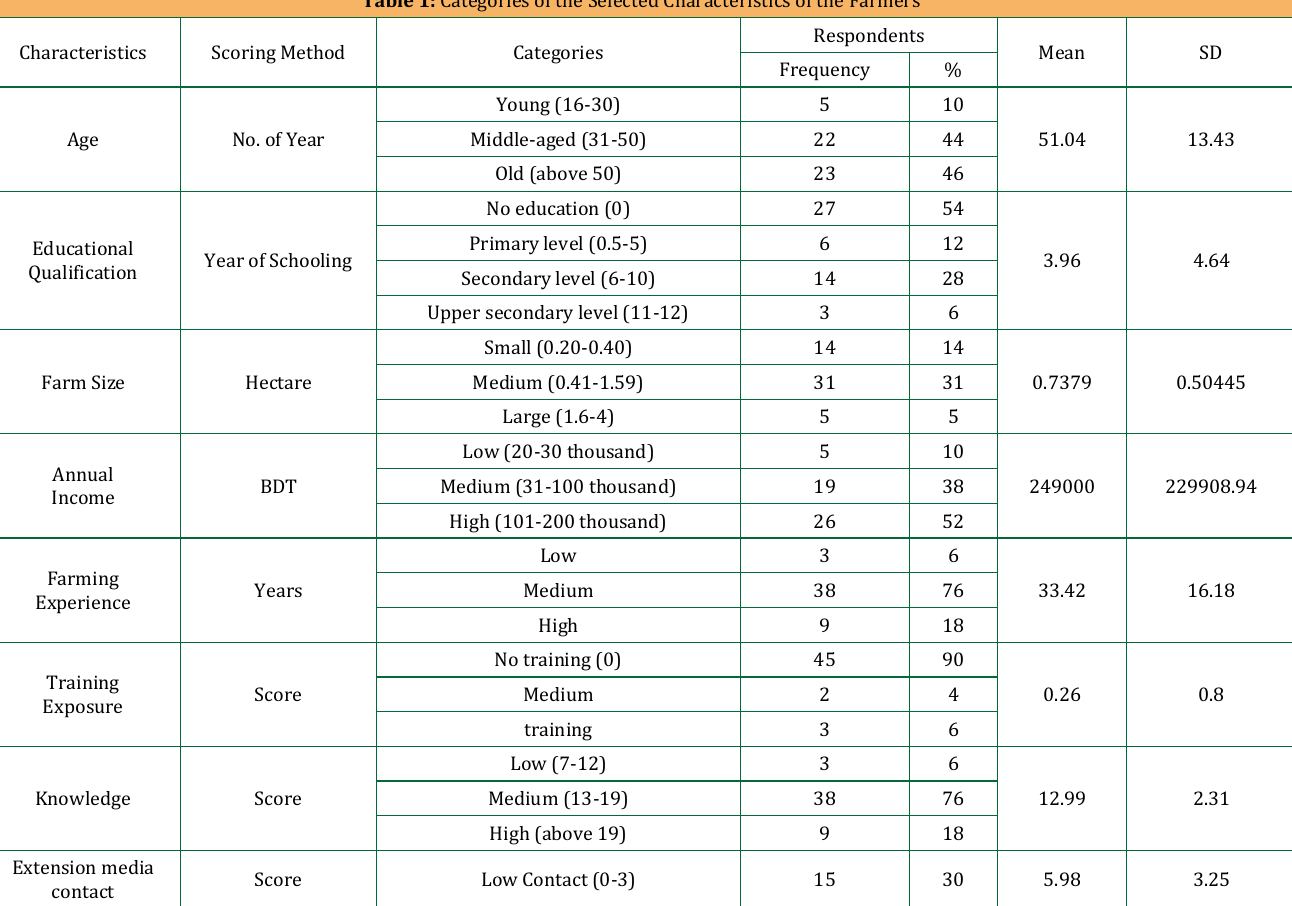
Table 1: Categories of the Selected Characteristics of the